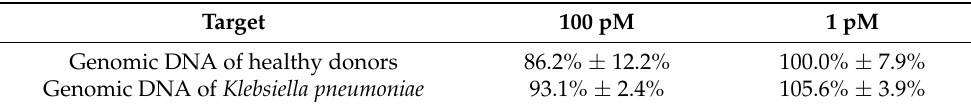
Table 1. Spike recovery of 100 pM and 1 pM in genomic DNAs of human and Klebsiella pneumoniae , respectively ( n =